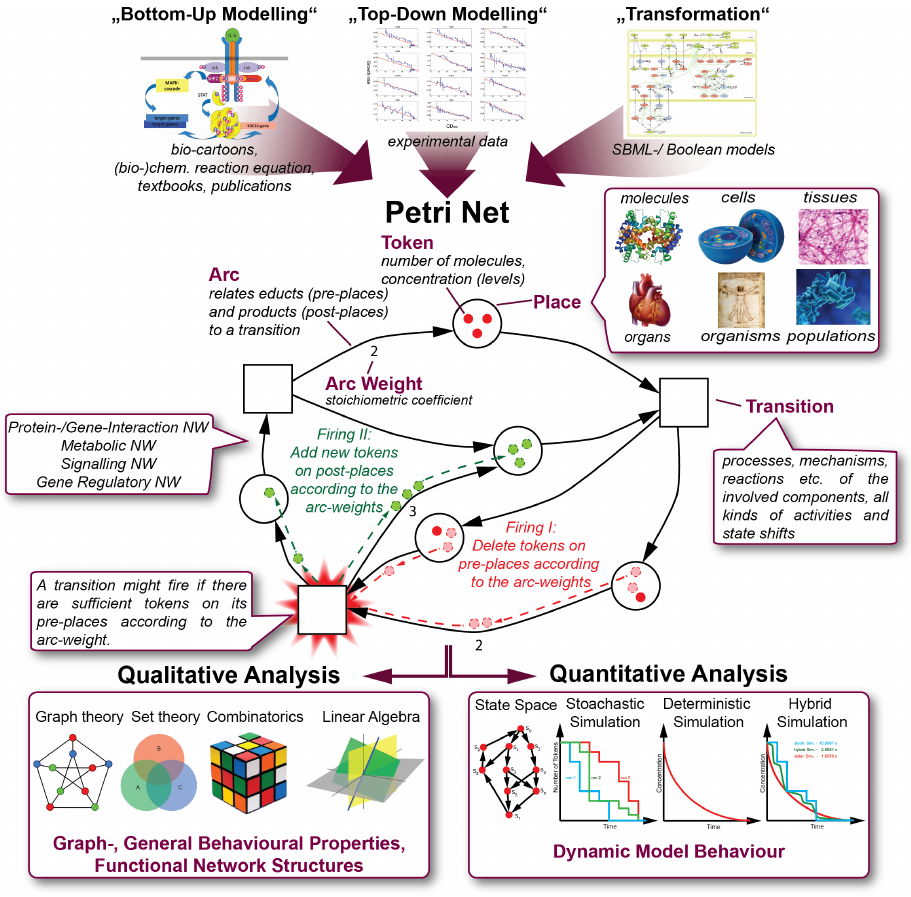
Figure 1: Overview of the PN framework. A PN is defined by two sets of nodes, places representing conditions (e.g. molecules) and transitions describ- ing events (e.g. reactions), that are connected via directed arcs carrying arc-weights to reflect the stoichiometry. Tokens , which reside only in places, indicate the value of a condition. A transition is a called enabled and may fire if the number of tokens (marking) on the pre-places is equal to or greater than the corresponding arc-weights. Only one transition can fire at a time. During the firing, the chosen enabled transition removes tokens from its pre-places and adds tokens to its post-places, both according to the arc-weight. After firing a new state is reached. Playing the so-called token game allows exploring the state